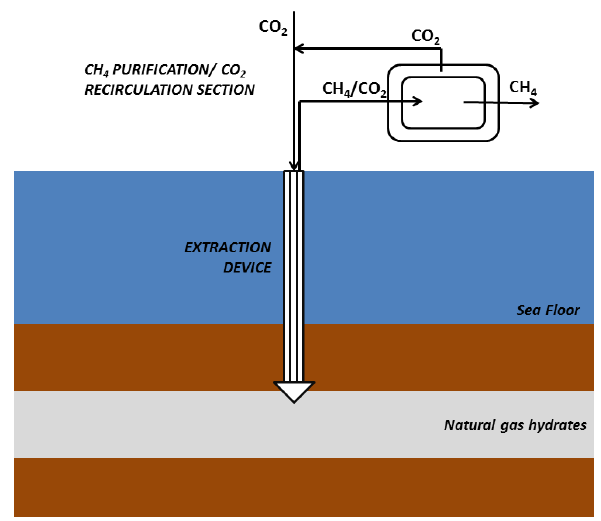
Figure 3. Membrane-based separation process for CH 4 recovery from NGH.